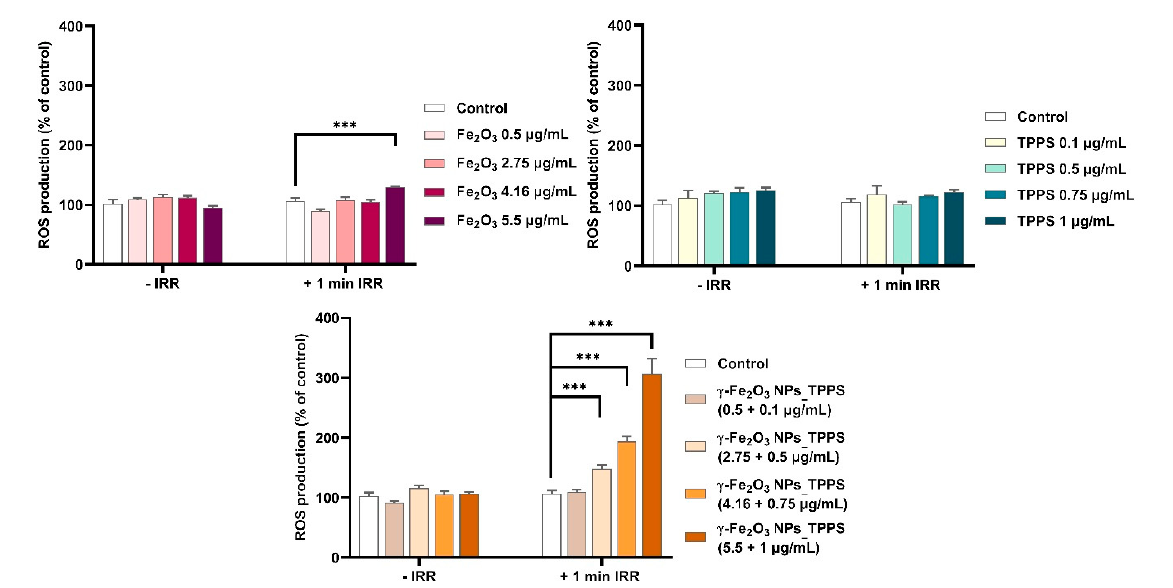
Figure 13. Intracellular ROS production after incubation for 24 h with different concentrations of γ -Fe 2 O 3 NPs, TPPS and their complex and exposure to no irradiation vs. 1 min irradiation ( λ ~ 405 nm, 1 mW/cm 2 ) conditions. Data ( n = 3) were expressed as percentages related to control ± standard deviation (SD). The results were considered statistically significant when *** p < 0.001 (sample vs. control).